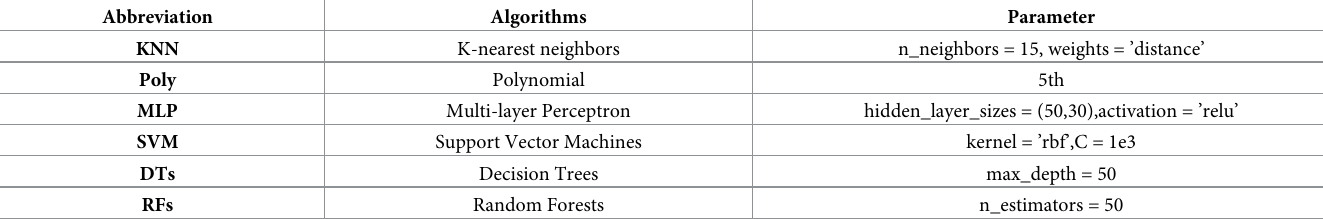
Table 5. Optimal parameters of the machine learning